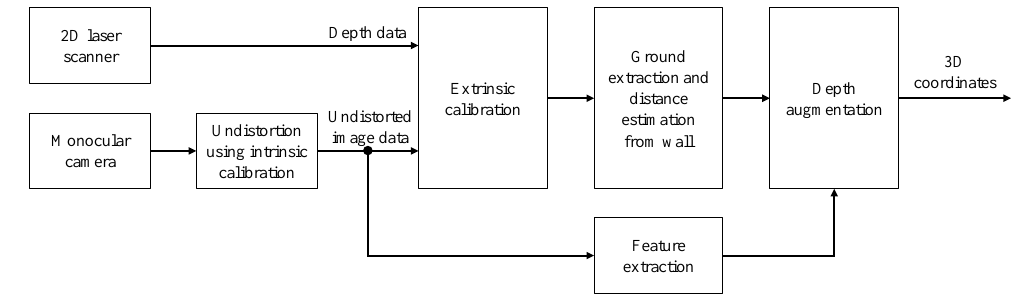
Figure 1. 3D coordinate estimation of the camera feature by the hybrid method of a monocular camera and a laser scanner. Depth data and image feature points are extracted from the 2D laser scanner and the monocular camera. 3D coordinates of features are